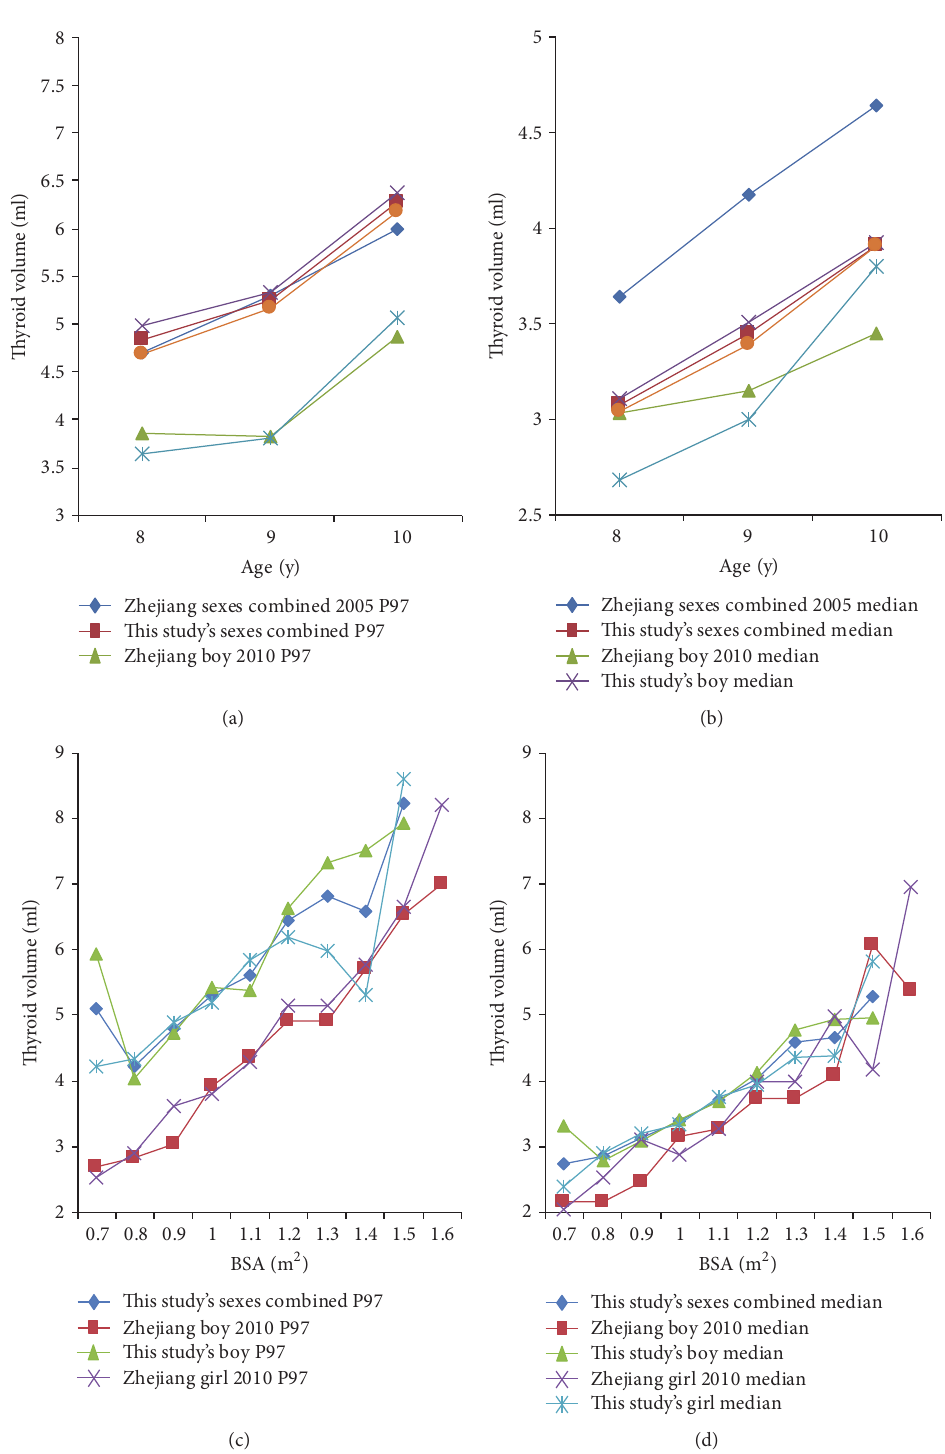
Figure 3: Comparison of median and P97 of thyroid volume between this study and previous reports in Zhejiang Province, China, by age and BSA. (a) and (b) show studies carried out from 2005 to 2013 [17, 18]; (c) and (d) show studies carried out from 2010 to 2013